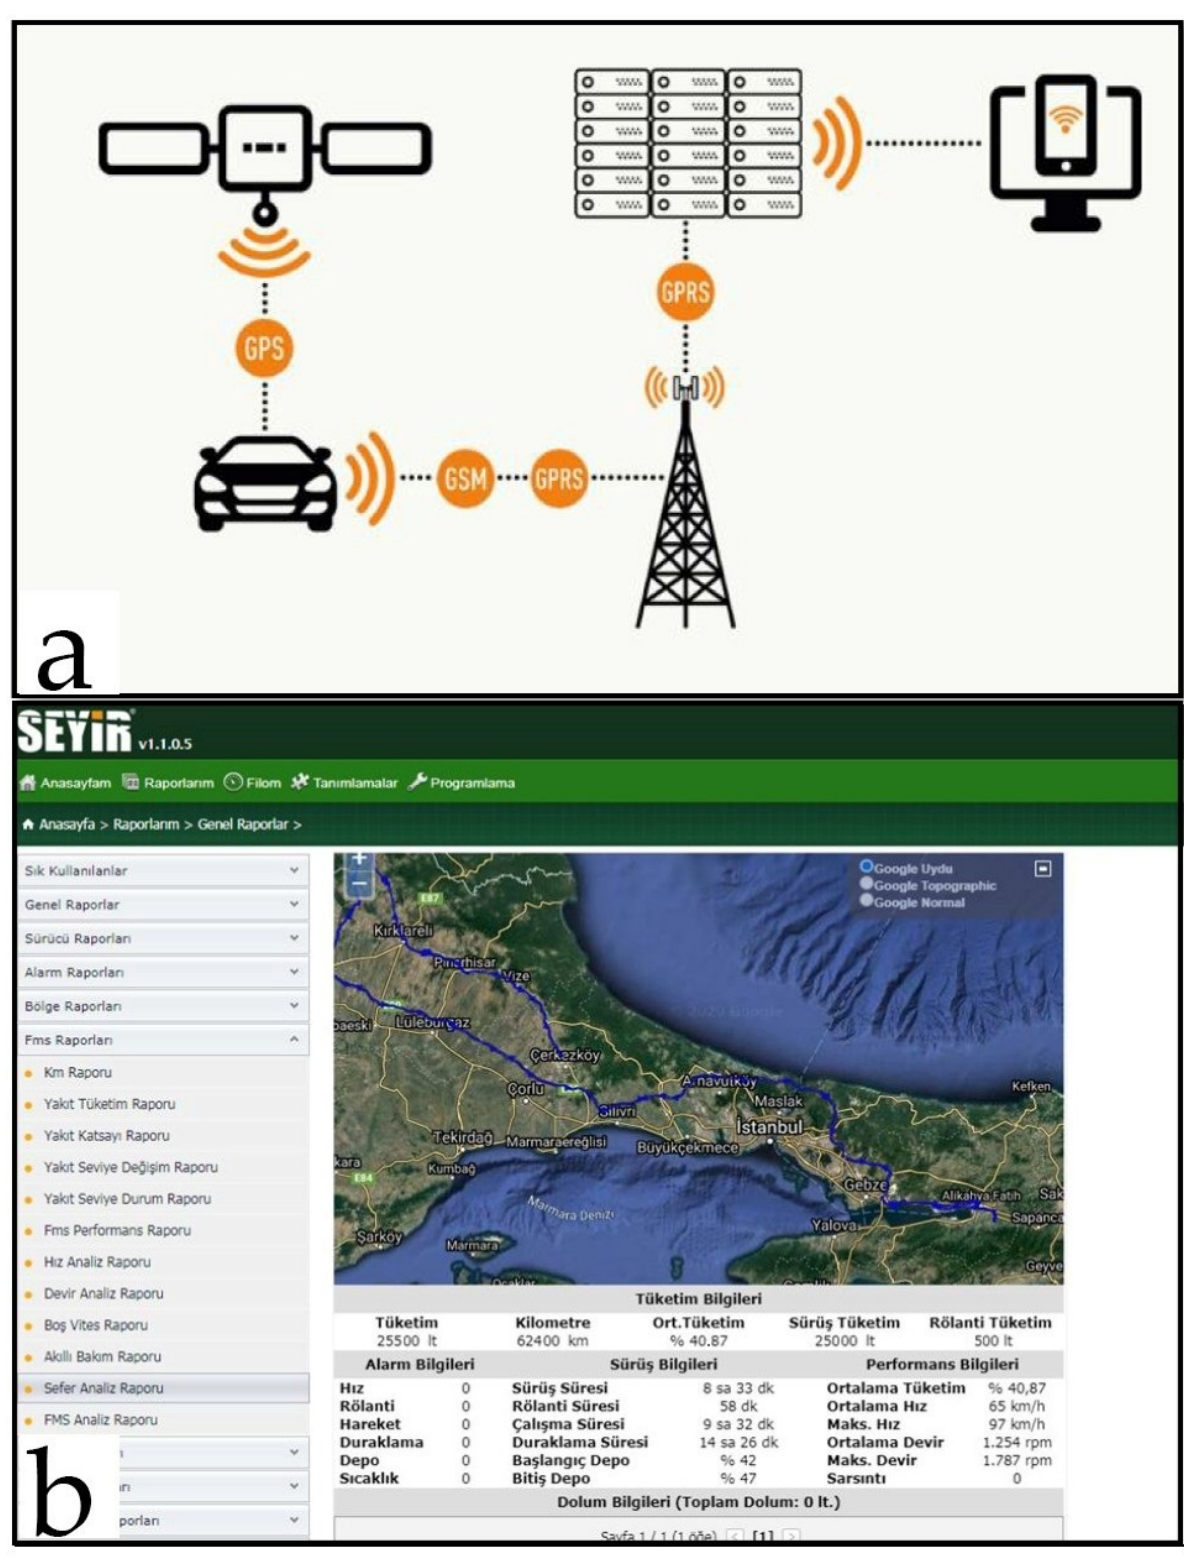
Figure 2. Vehicle tracking system general view ( a ) and vehicle tracking system web-based report view ( b ).